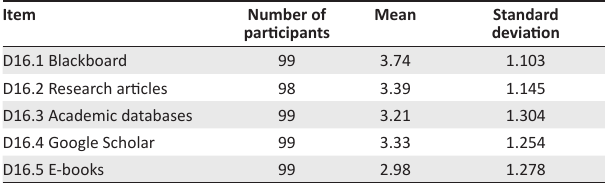
TABLE 4: Descriptive statistics for the frequency of using smart devices to access sources of